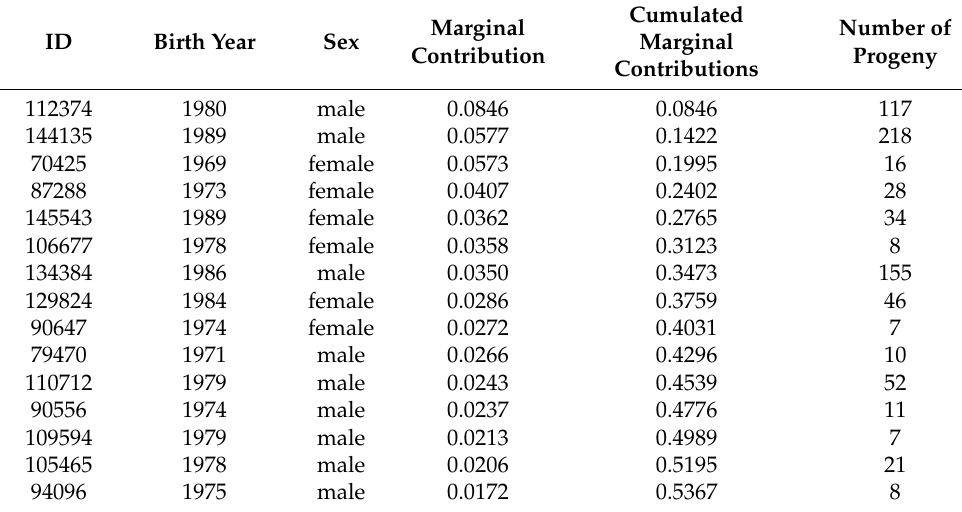
Table 2. Ancestors with the greatest marginal contributions onto the Deutsch Drahthaar refer- ence population. ID Birth Year Sex